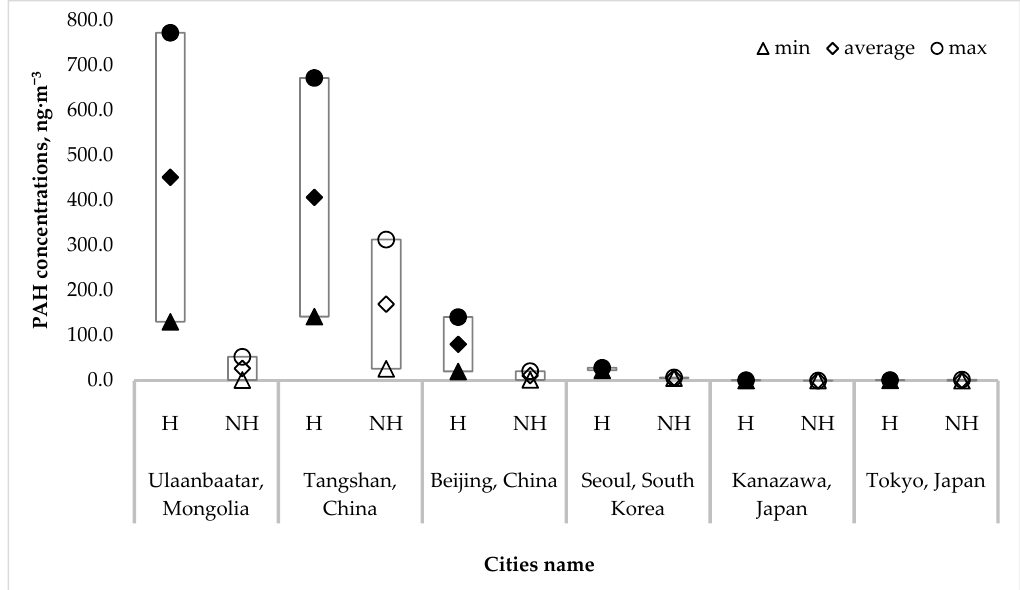
Figure 4. Compared concentrations of PAHs in the heating (H) and non-heating (NH) periods of select Asian cities.